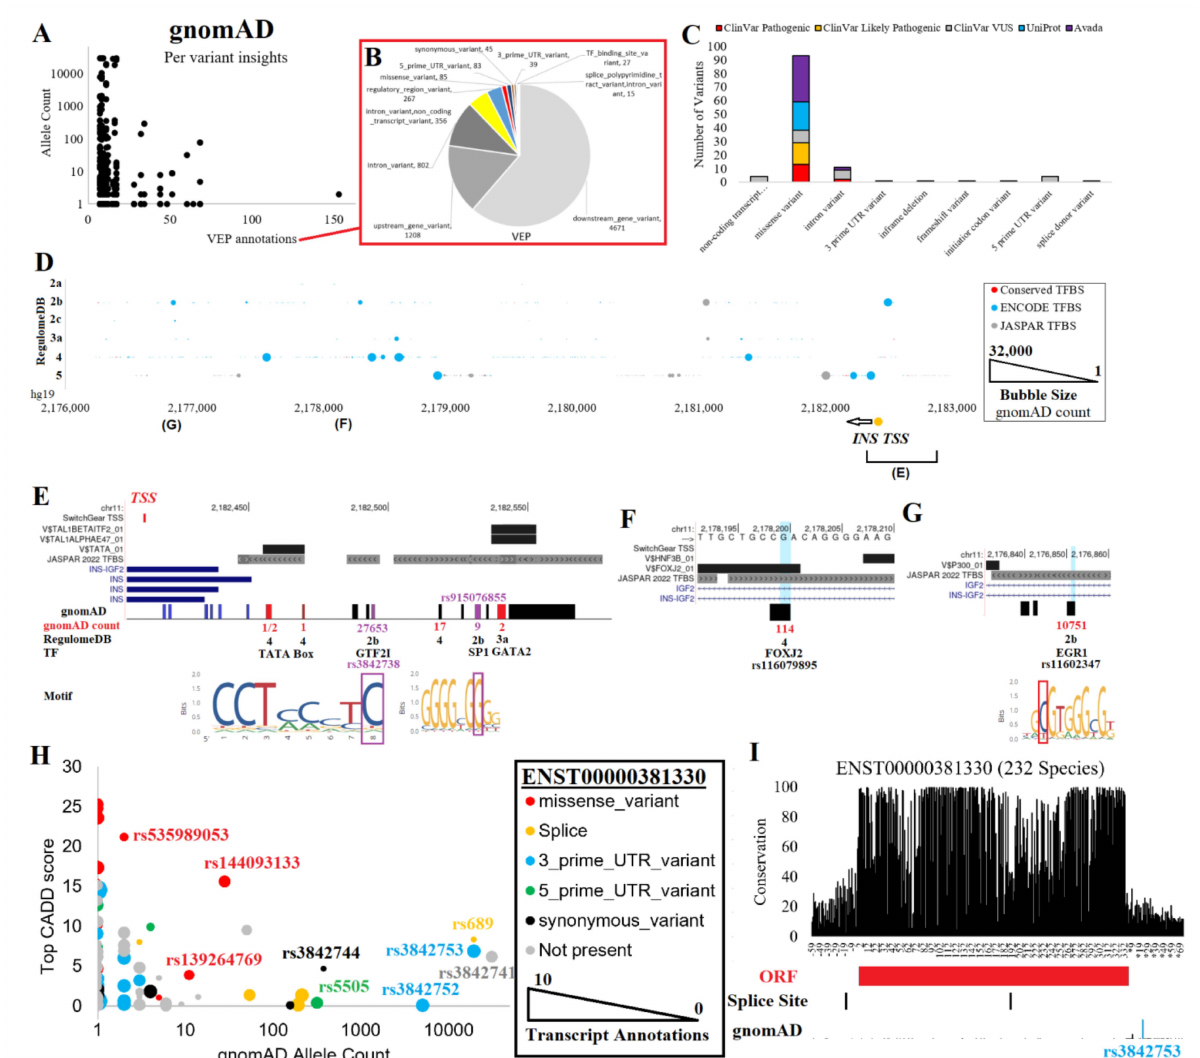
Figure 3. INS variants. ( A ) gnomAD variants for the region shown in Figure 1C. The x-axis shows the number of VEP annotations for each unique variant, and the y-axis shows the gnomAD allele count. ( B ) The red box calls out the breakdown of VEP annotations over all variants. ( C ) Unique variant annotations for ClinVar, UniProt, and Avada. ( D ) Noncoding variant annotations. The x-axis shows the genome coordinates (hg19), the y-axis shows the RegulomeDB score, and the bubble size represents the gnomAD count. Red dots denote those within a conserved transcription factor binding site (TFBS), cyan dots for those within a known ENCODE ChIP-Seq binding event, and gray dots for those within a JASPAR-predicted TFBS. Below is the INS transcriptional start site (TSS) and two regions covered in Panels E-G. ( E ) Annotation of variants within the promoter of INS . The TSS is shown in red. Conserved TFBS and JASPAR are shown above INS transcripts. On the bottom are the gnomAD variant counts for RegulomeDB predictions or for those that fall within a conserved TFBS. ( F ) A downstream enhancer site with rs116079895 that is predicted to alter a FOXJ2 conserved TFBS. ( G ) A downstream enhancer site with rs11602347 predicted using RegulomeDB to alter an EGR1 binding site. ( H ) Transcript annotations from VEP. Colors represent the labeled ENST00000381330 annotations, the primary INS transcript. The INS transcript annotations found outside of ENST00000381330 are in gray. The x-axis shows the gnomAD allele count, the y-axis shows the top CADD score for functionality, and the bubble size shows the number of transcript annotations for each variant. ( I ) Conservation of 232 species transcripts for ENST00000381330 at the RNA base level. Below are the open reading frame (ORF), transcript splice sites, and gnomAD allele